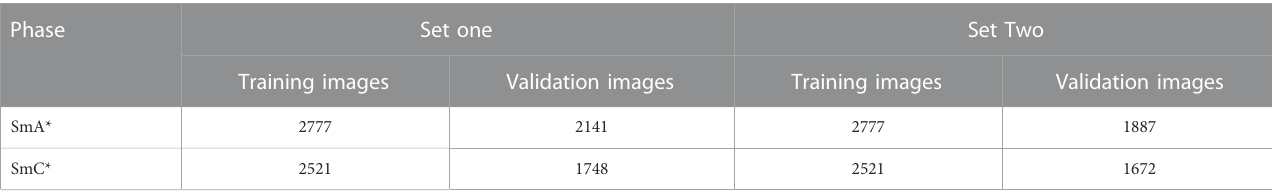
TABLE 3 Number of training and validation images in the fl uid smectic-hexatic datasets.